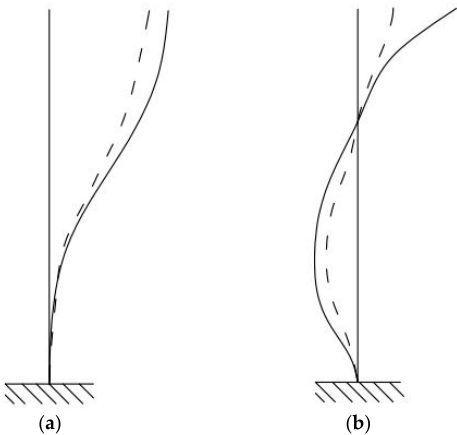
Figure 10. Structural mode of vibration. The solid line presents the results without water and the dotted line presents the results with water. ( a ) First-order mode of vibration and ( b ) second-order mode of